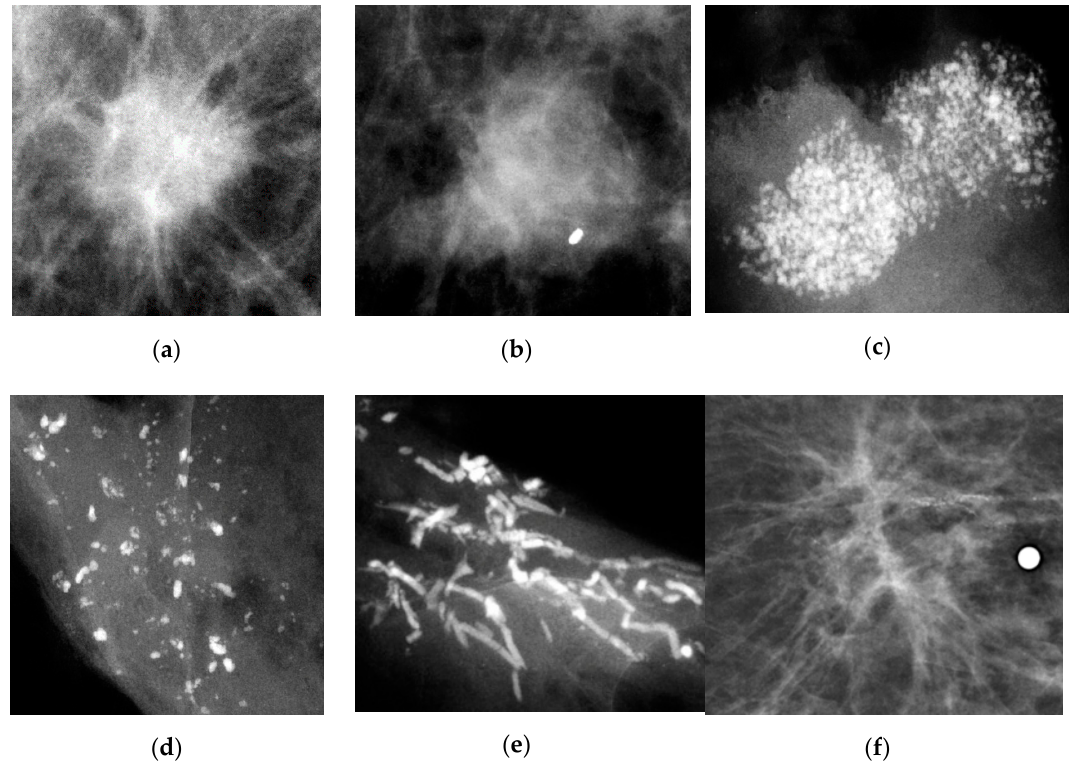
Figure 6. Types of mammographic appearance including Stellate, Circular, Powdery, Casting, Crushed stone-like and Architecture distortion. ( a ) Stellate; ( b ) Circular; ( c ) Powdery; ( d ) Crushed stone-like; ( e ) Casting; ( f ) Architecture distortion.